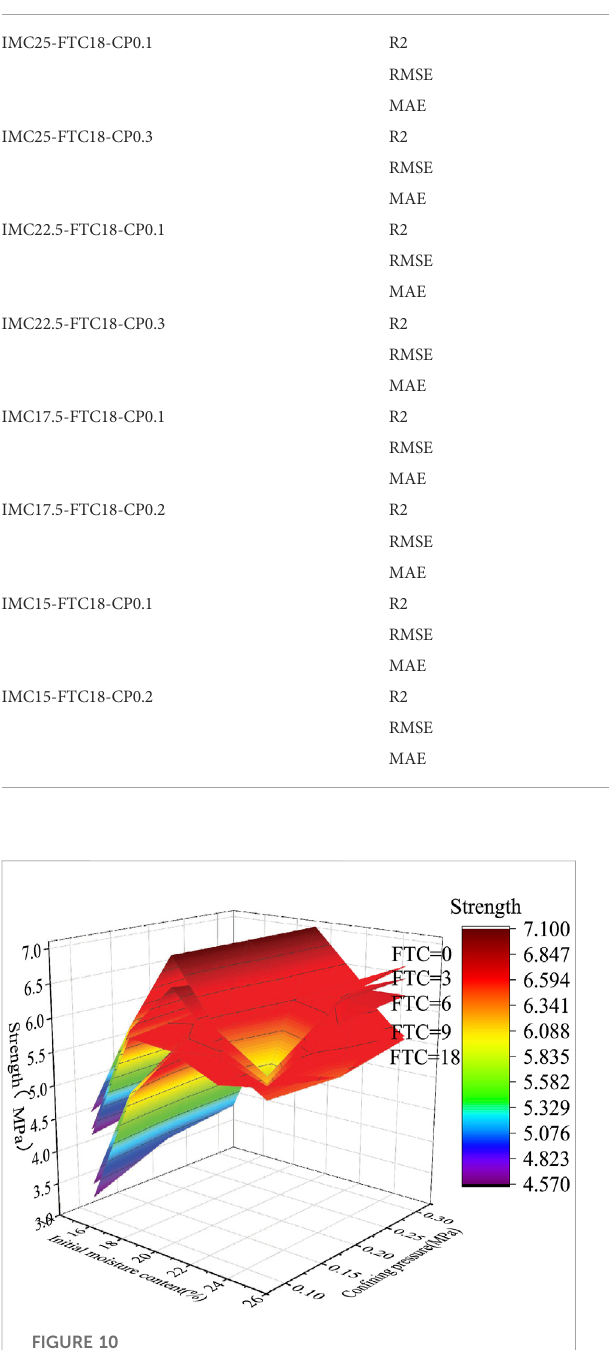
FIGURE 11 Three dimensional changes of freeze-thaw cycles, initial moisture content and strength under different con fi ning pressures.